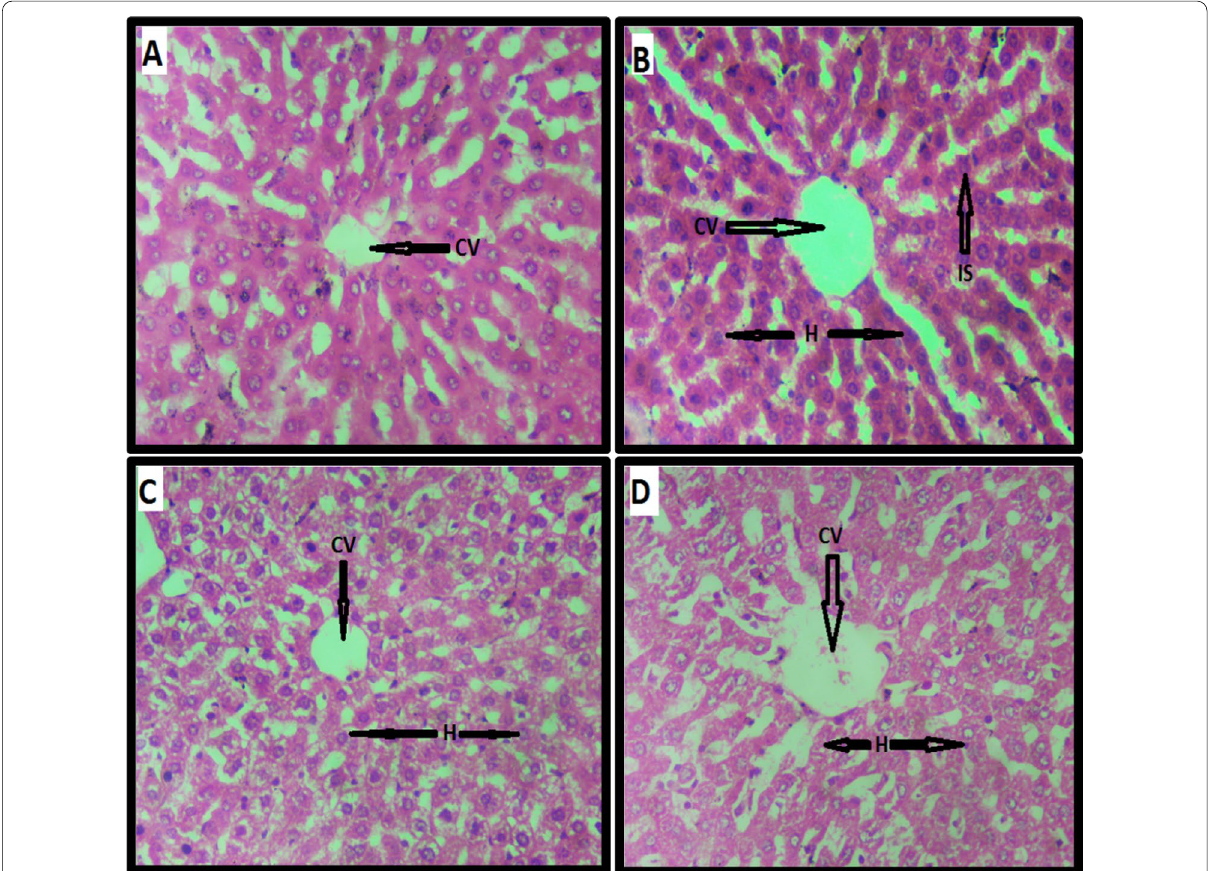
Fig. 4 Liver sections (H&E stained) (200X) of A control rats, B chloroform extract treated rats, C ethanol extract treated rats and D n-hexane extract treated rats after 14 days. CV central vein, IS interstitial space and H